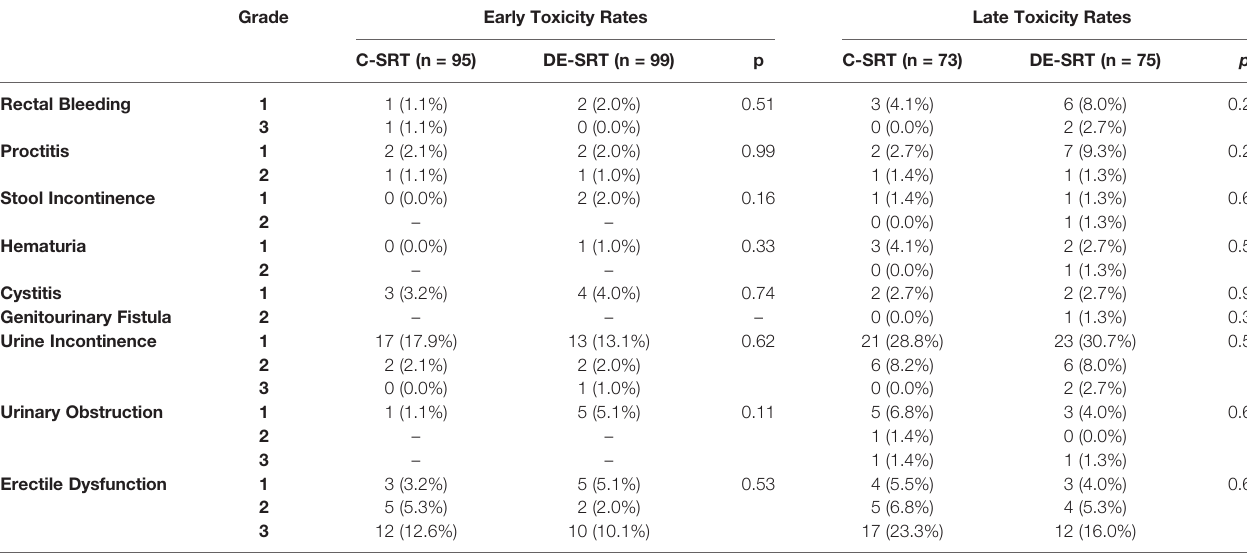
TABLE 4 | Comparison of newly diagnosed or worsened early and late toxicity rates of conventional salvage radiotherapy (C-SRT) versus dose-escalated salvage radiotherapy (DE-SRT) in the overall group including all patients.